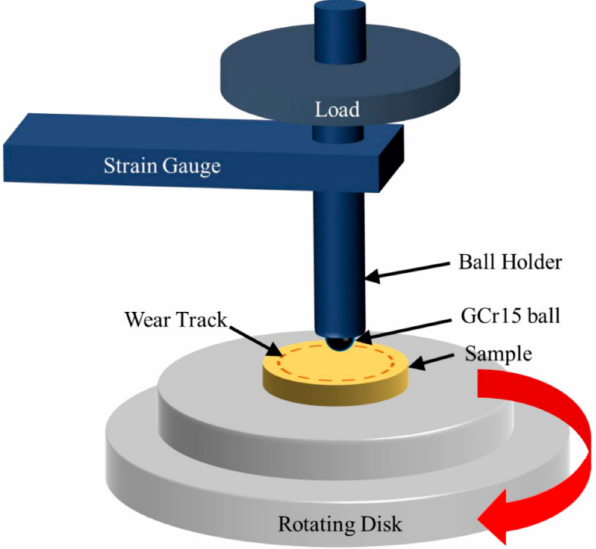
Figure 2. Schematic depicting the ball-on-disk friction